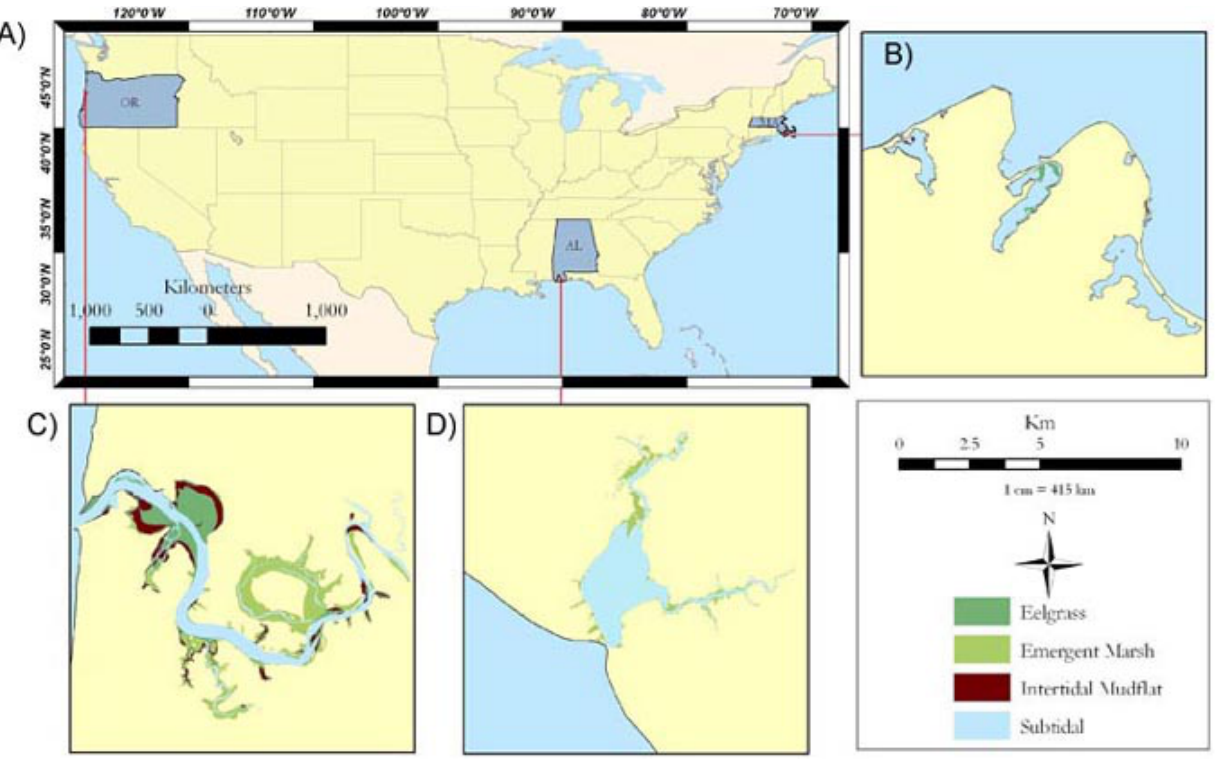
Fig. 1. (A) Location of the three estuarine study sites showing one on each coast of the conterminous U. S. (B) Lagoon Pond, Martha’s Vineyard, showing location of eelgrass habitat. (C) Yaquina Bay, Oregon, showing emergent marsh, mudflat, and eelgrass habitats. (D) Weeks Bay, Alabama, showing emergent marsh